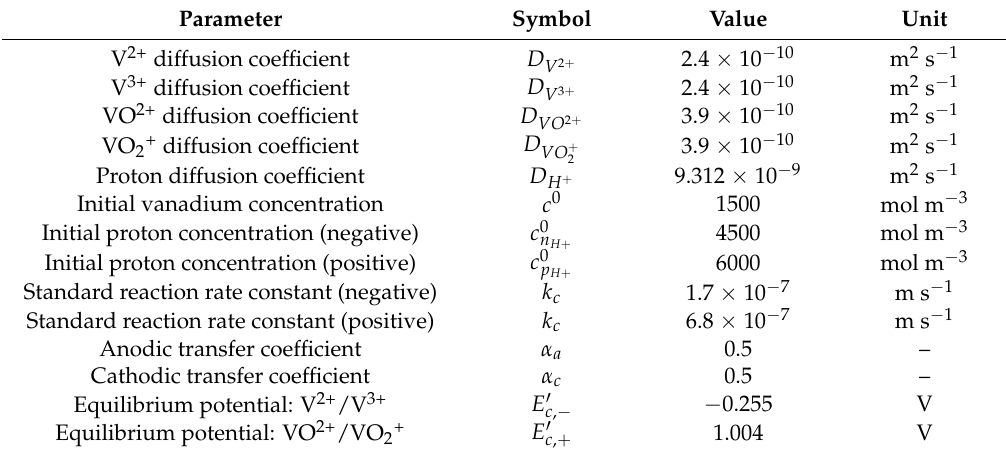
Table 6. Electrochemical parameters from You et al. [8].